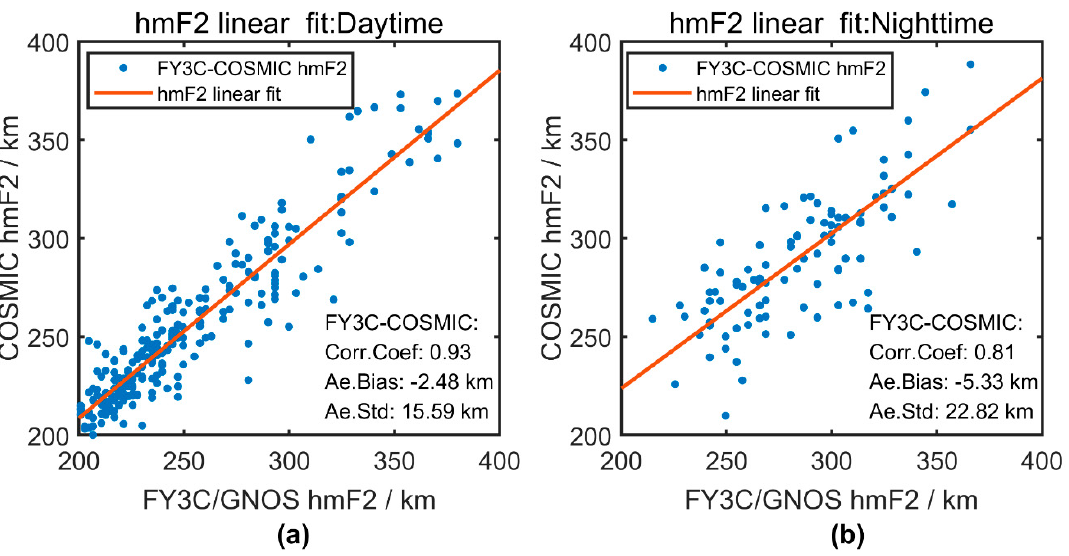
Figure 5. Linear fits of hmF2 between FY3C/GNOS and COSMIC at daytime and nighttime during 2016.035 and 2017.035: ( a ) the linear fit of hmF2 between FY3C/GNOS (horizontal axis) and COSMIC (vertical axis) at 0600–1800LT, corresponding to daytime; ( b ) the linear fit of hmF2 at 1800–0600LT, corresponding to nighttime. The correlation coefficient of hmF2 data pairs, the bias, and std of absolute errors of matched hmF2 data pairs at daytime and nighttime are presented in the bottom right corner of (a) and (b), respectively.